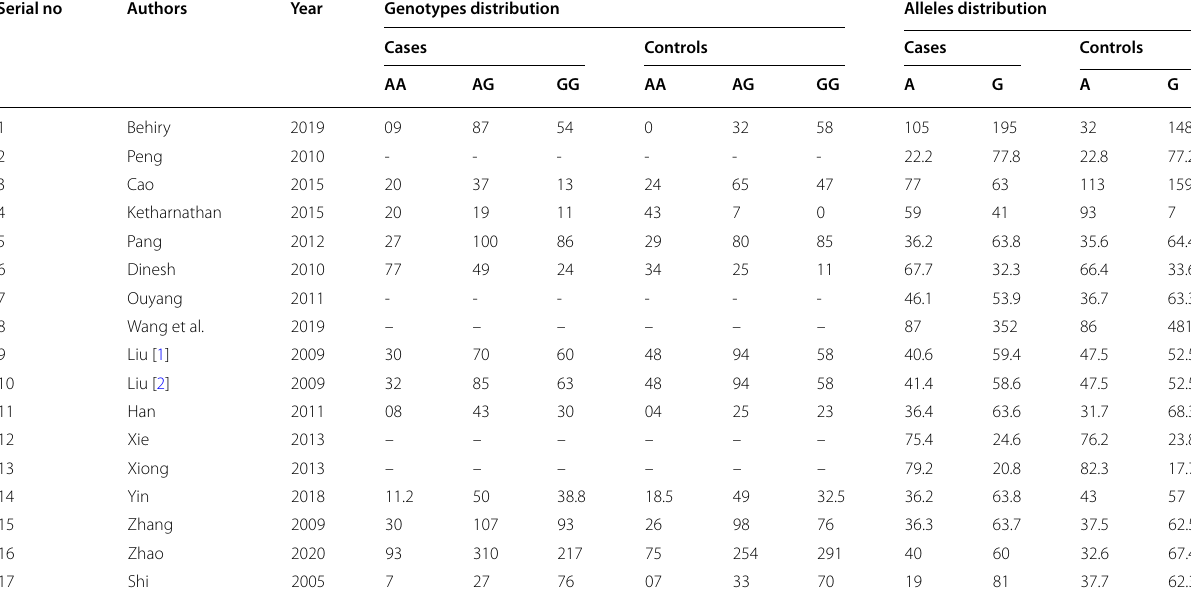
Table 2 The allele frequencies and genotypes distributions of NKX2-5 polymorphism